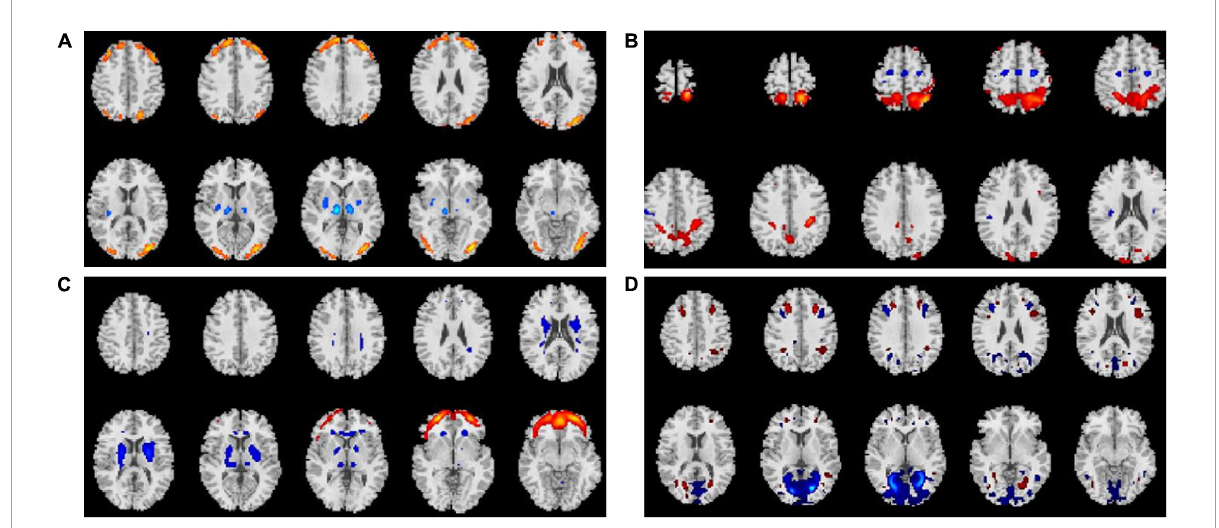
FIGURE2 Comparison of gFCDs before versus after 24-week treatments inclusive of r-TMS. (A) O-rTMS + Li group. (B) O-rTMS group. (C) F-rTMS + Li group. (D) . F-rTMS group.